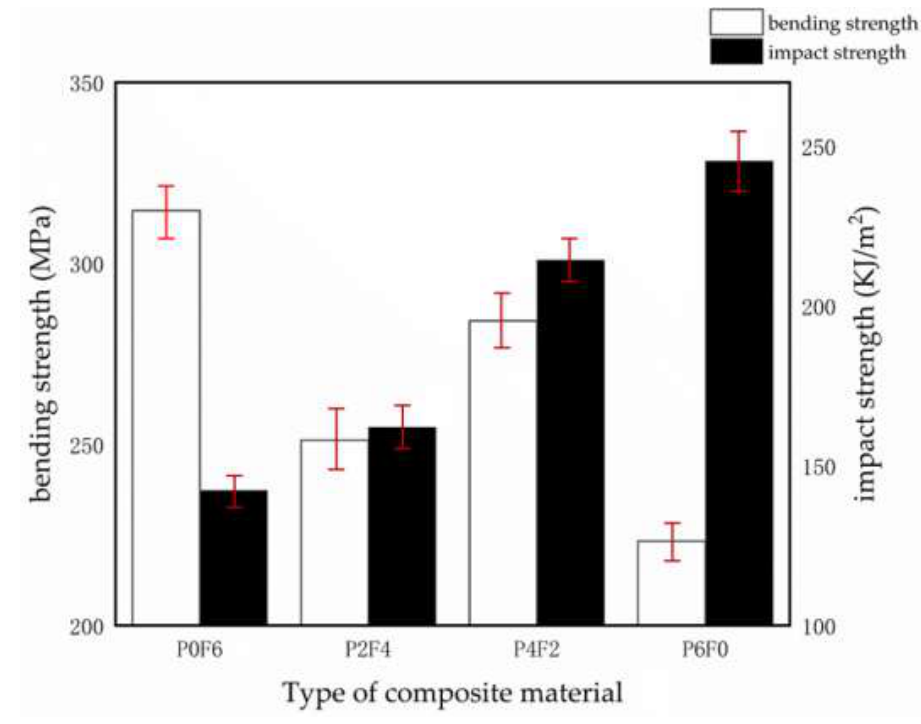
Figure 8. Effect of PPS form on mechanical properties of composites.